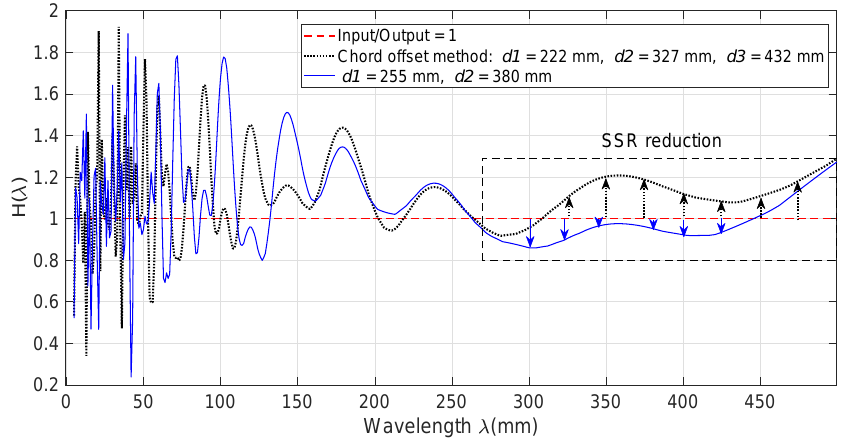
Figure 5. Minimized residual results with two sensors using the chord offset